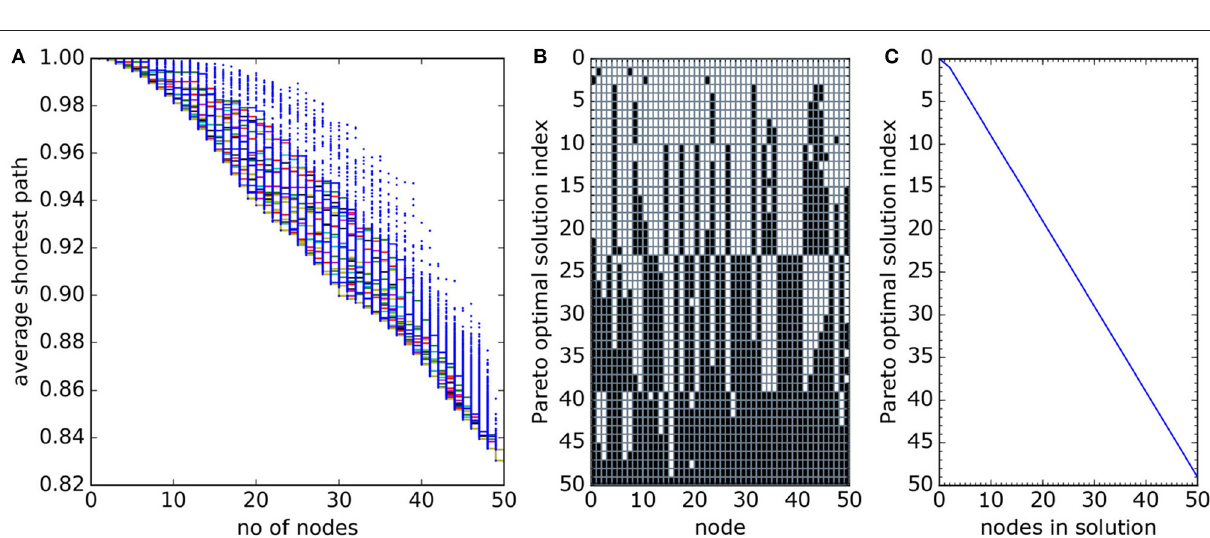
FIGURE 8 | Estimated Pareto front for the 50-node network. (A) Successive iterative estimates of the Pareto front (solid colored lines) with blue dots showing computed values of average shortest path for each network. (B) The structure of the Pareto optimal solutions and, (C) the number of nodes in each Pareto optimal solution. Notice the region of slightly “better” (convex front shape in A ) solutions around 30 nodes and the sharp changes in structure of the 50-node Pareto optimal solution between solution index numbers 22 and 23, and again between 38 and 39 in panel (B)